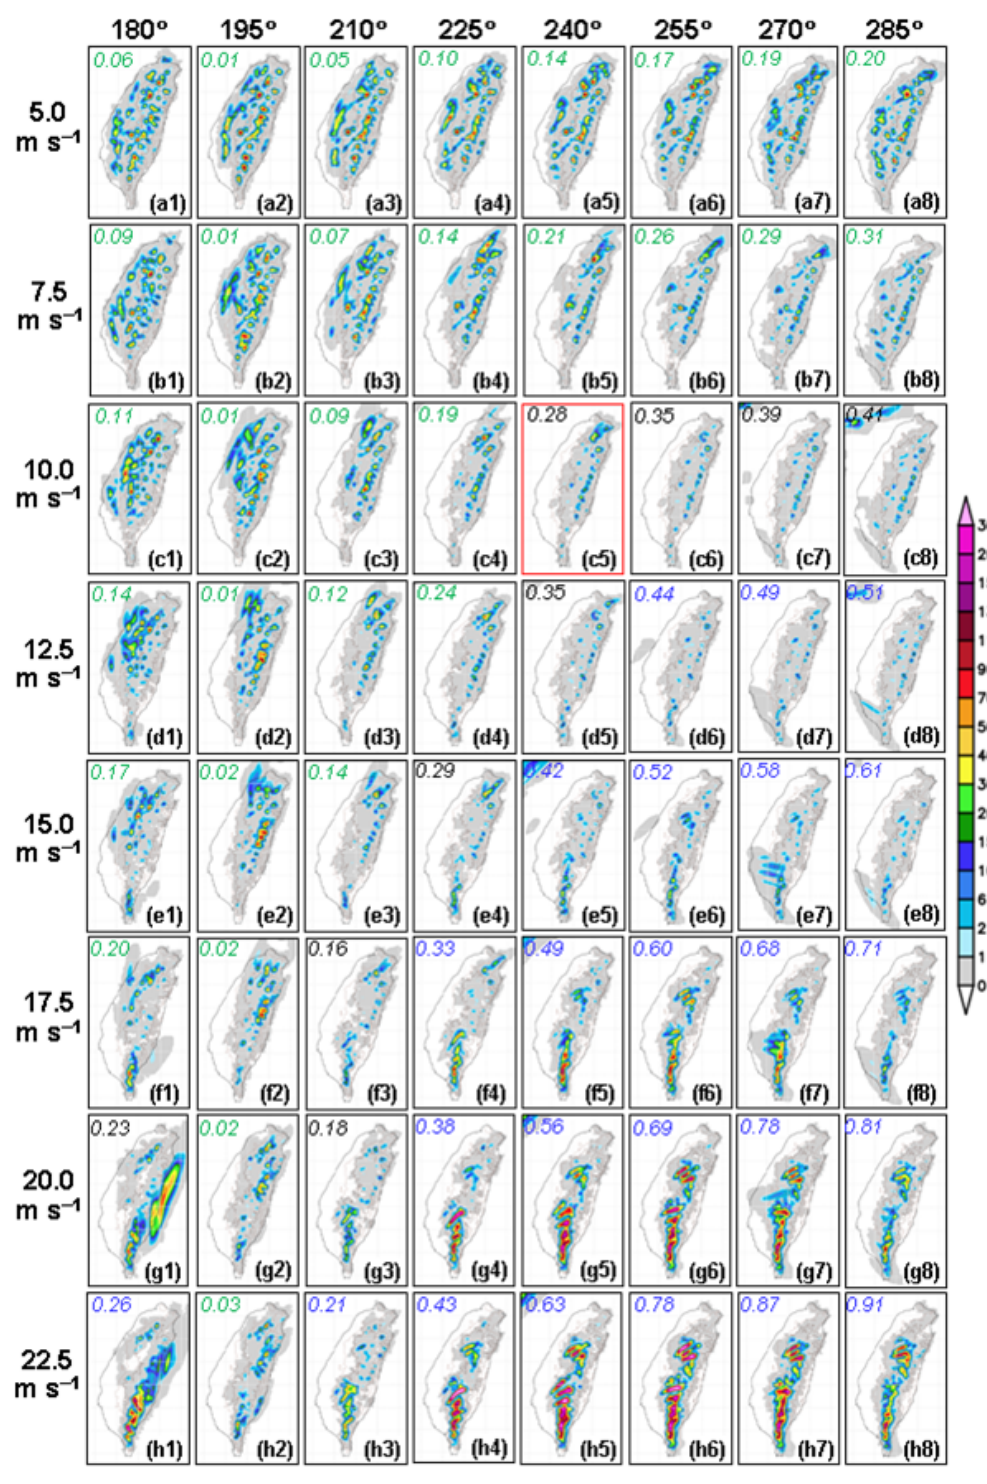
Figure 7. Mean daily rainfall distribution (mm, per 24h, scale on the right) over Taiwan in the 8 × 8 experiments of different wind directions (every 15 ◦ from 180–285 ◦ ) and speeds (every 2.5ms − 1 from 5.0–22.5ms − 1 ), as labeled on top (for direction) and the left (for speed) from (a1) to (h8). The averages are over 2d (2–50h). The CTL experiment (240 ◦ , 10ms − 1 ) is shown in (c5) using a red box. The value of Fr w is labeled in the upper-left corner in each panel, and blue, green, and black colors indicate the rainfall regime of terrain uplift, island circulation, and mixed,